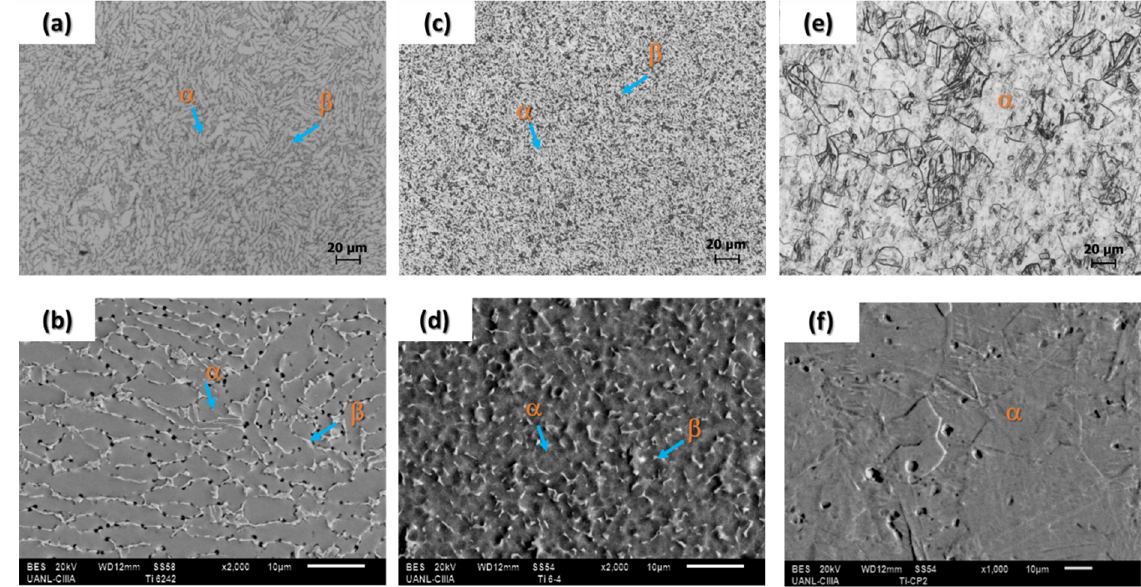
Figure 1. OM and SEM micrograph of titanium alloys (initial conditions): ( a , b ) Ti-6Al-2Sn-4Zr-2Mo, ( c , d ) Ti-6Al-4V, and ( e , f ) Ti CP2.